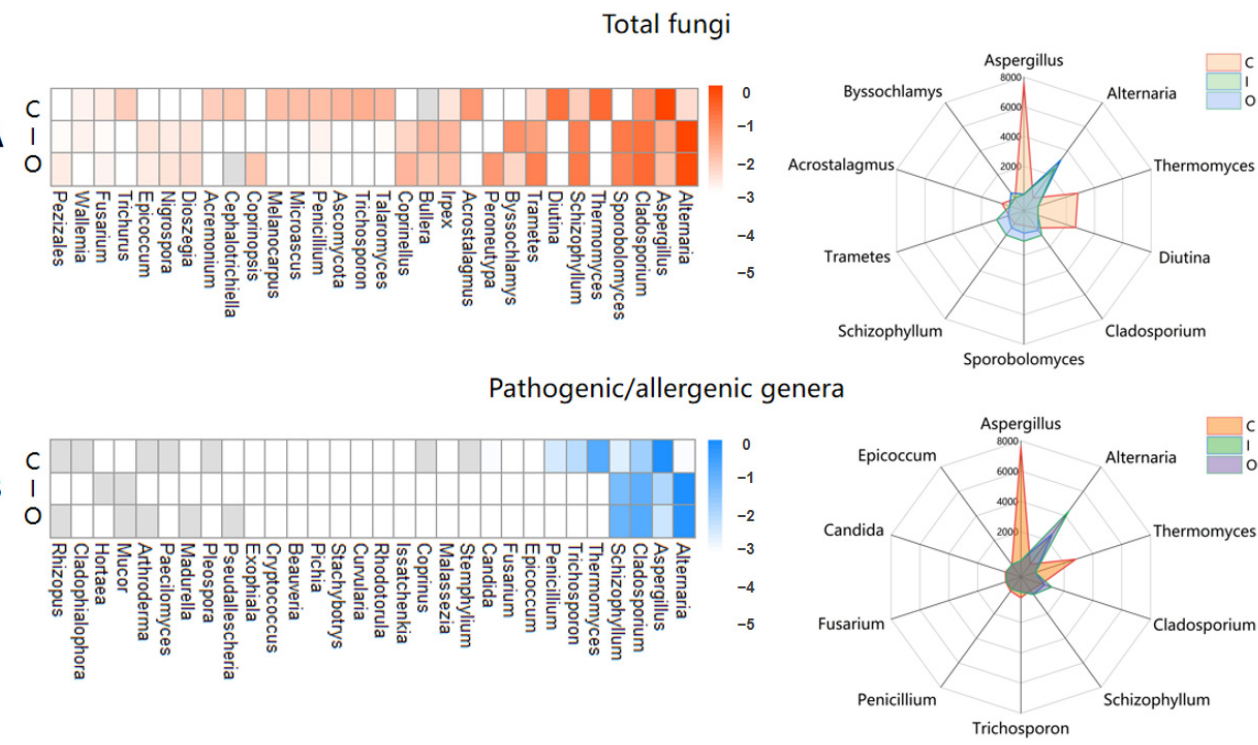
Figure 2. The dominant fungi and pathogenic/allergenic genera in compost piles (C), inside (I), and outside air (O) of composting workshop. ( A ), the relative abundance (Log value) of the top 30 dominant fungi by heat map and the estimation of absolute abundance (EAA) of 10 dominant fungi by radar map; ( B ), the relative abundance (Log value) of 30 pathogenic/allergenic genera by heat map and the EAA of 10 dominant pathogenic/allergenic genera by radar map.